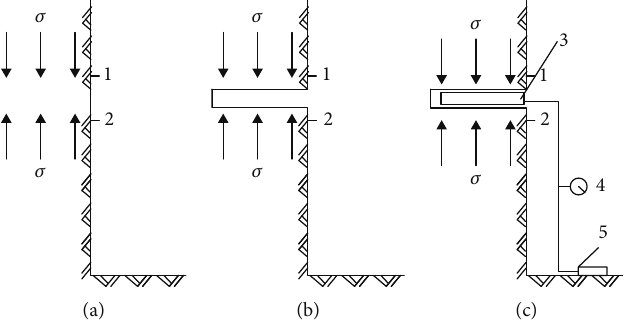
Figure 3: Test process. (a) Measuring point arrangement. (b) Slot cut. (c) Partial recovery deformation. 1-displacement column 1. 2- displacement column 1. 3- fl at jack. 4-pressure gauge. 5-oil pump.